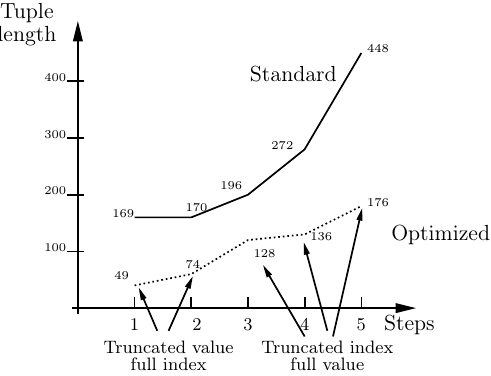
Fig. 3. Tuple length in bits over the steps of Wagner’s algorithm in the basic and the optimized